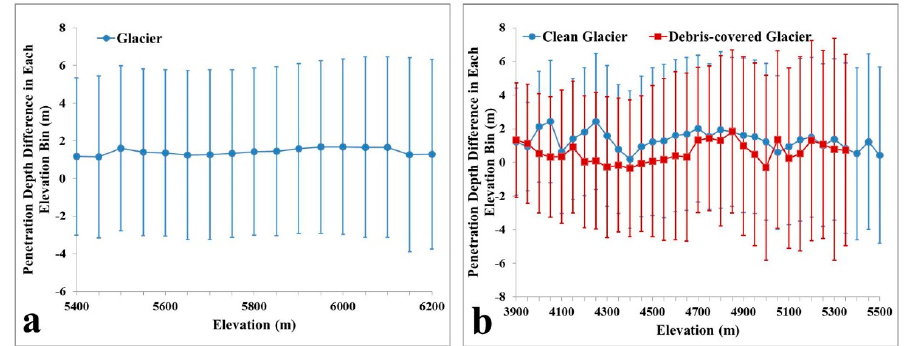
Figure 5. Penetration depth (expressed by the mean ± standard deviation) estimated as the difference between SRTM-X and SRTM-C DEMs in each 50 m elevation bin in the study area: ( a ) WNM and ( b ) ENM; clean and debris-covered glaciers in the ENM delineated as described in the glacier mapping part in Section 3.2.